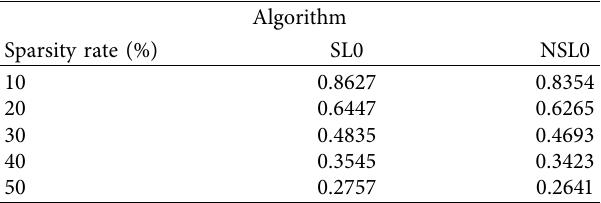
Table 4: Reconstruction error comparisons between SL0 and NSL0.